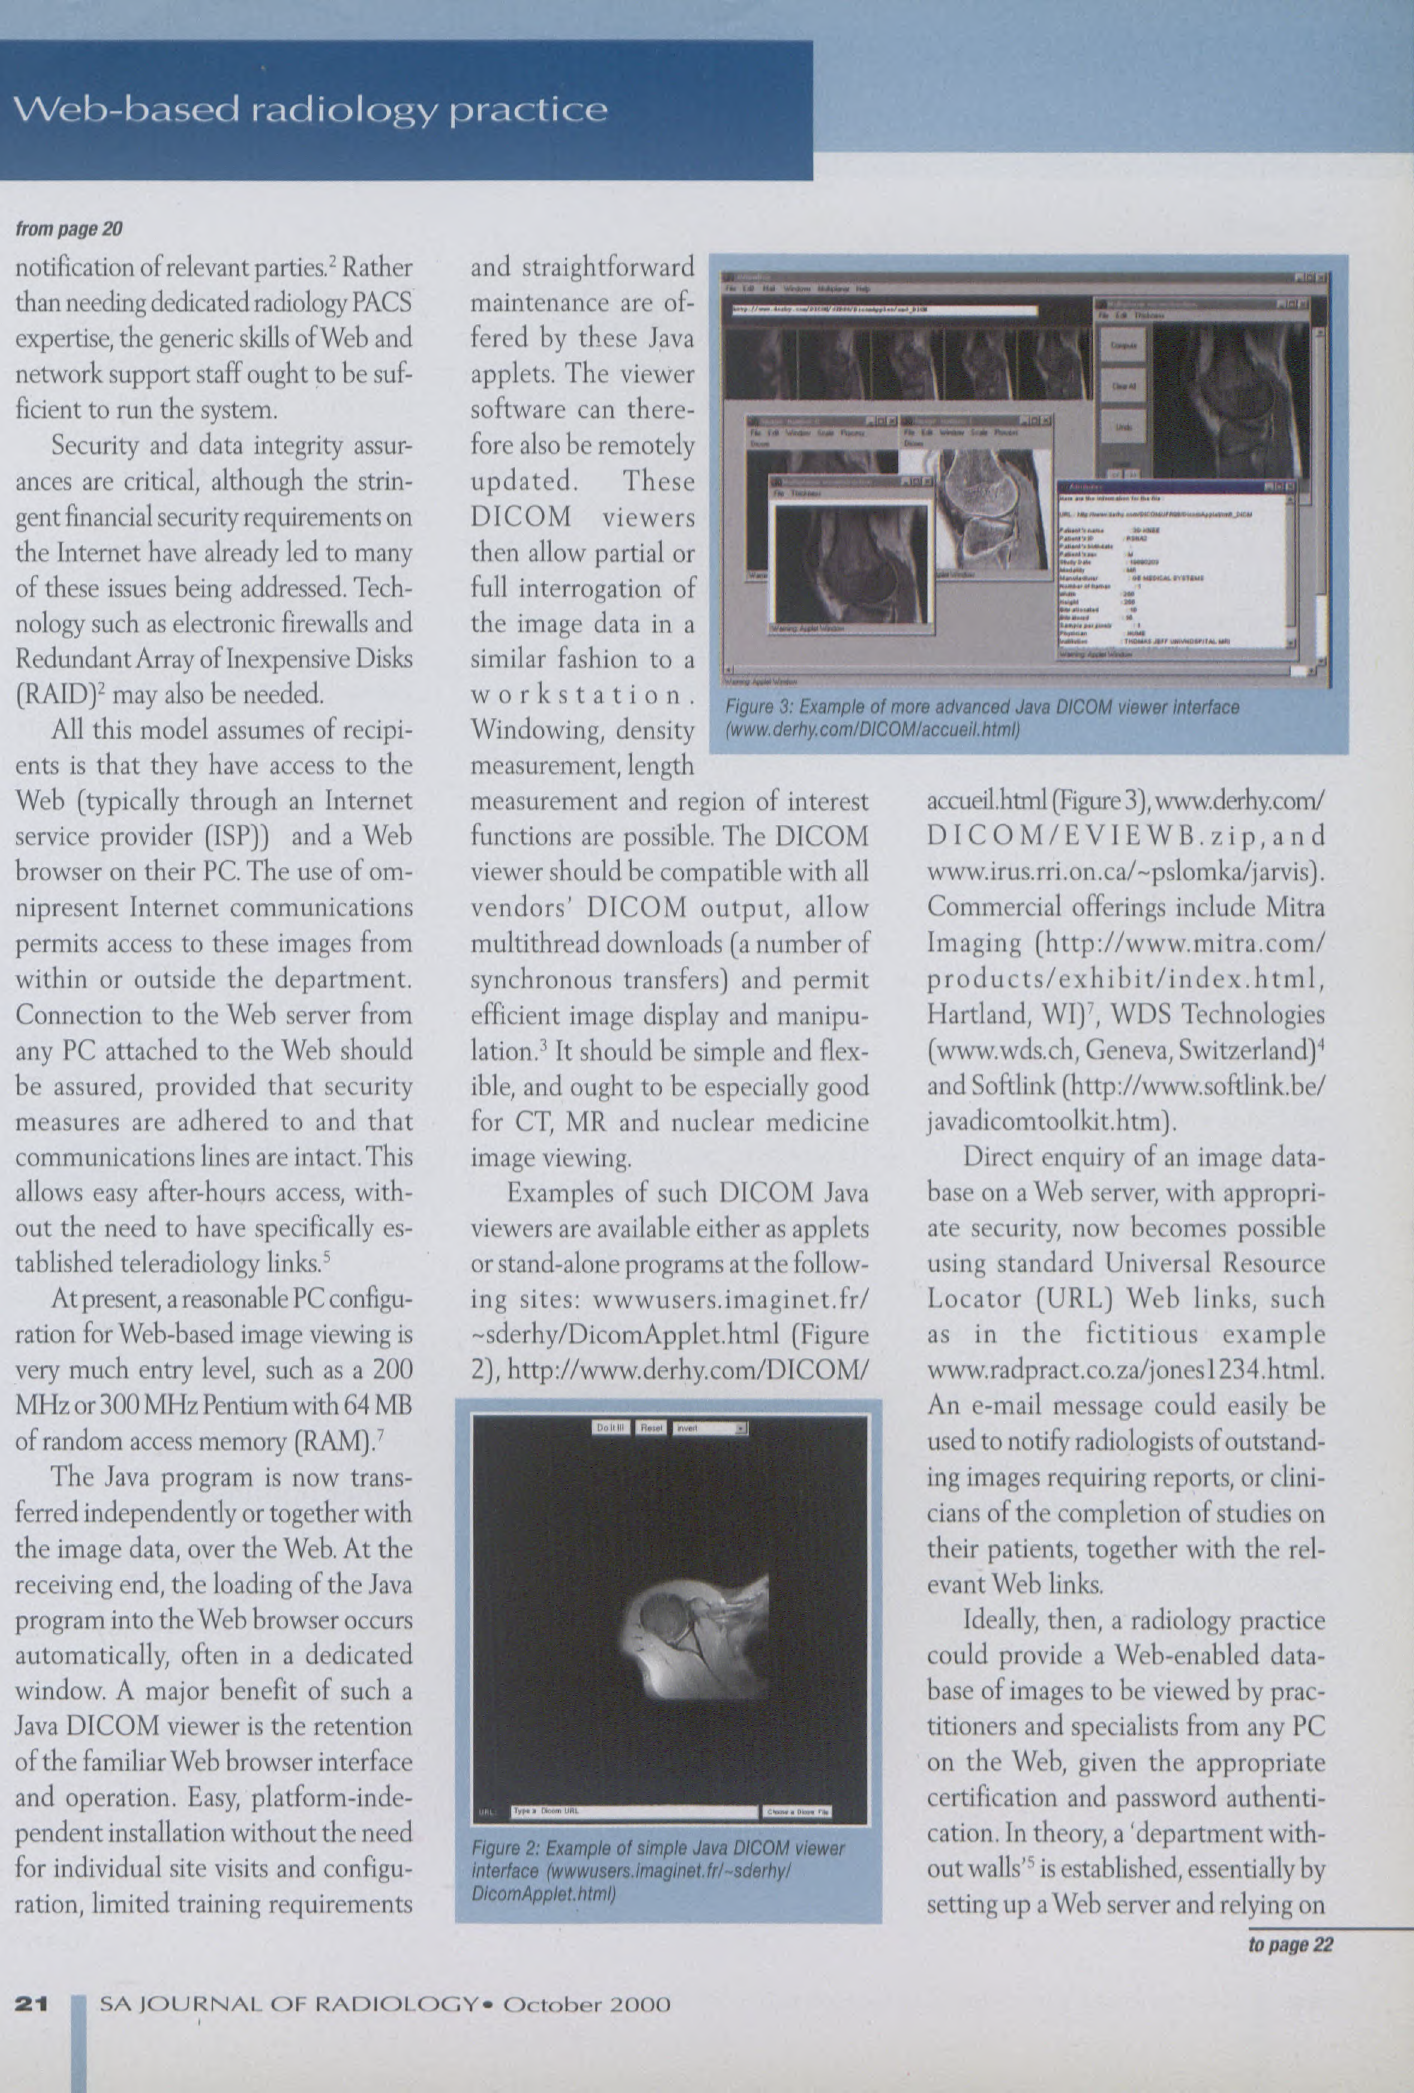
Figure 3: Example of mora advanced Java DICOM viewer interlace Windowing, density (www.derhy.comIDICOMlaccueil.html)